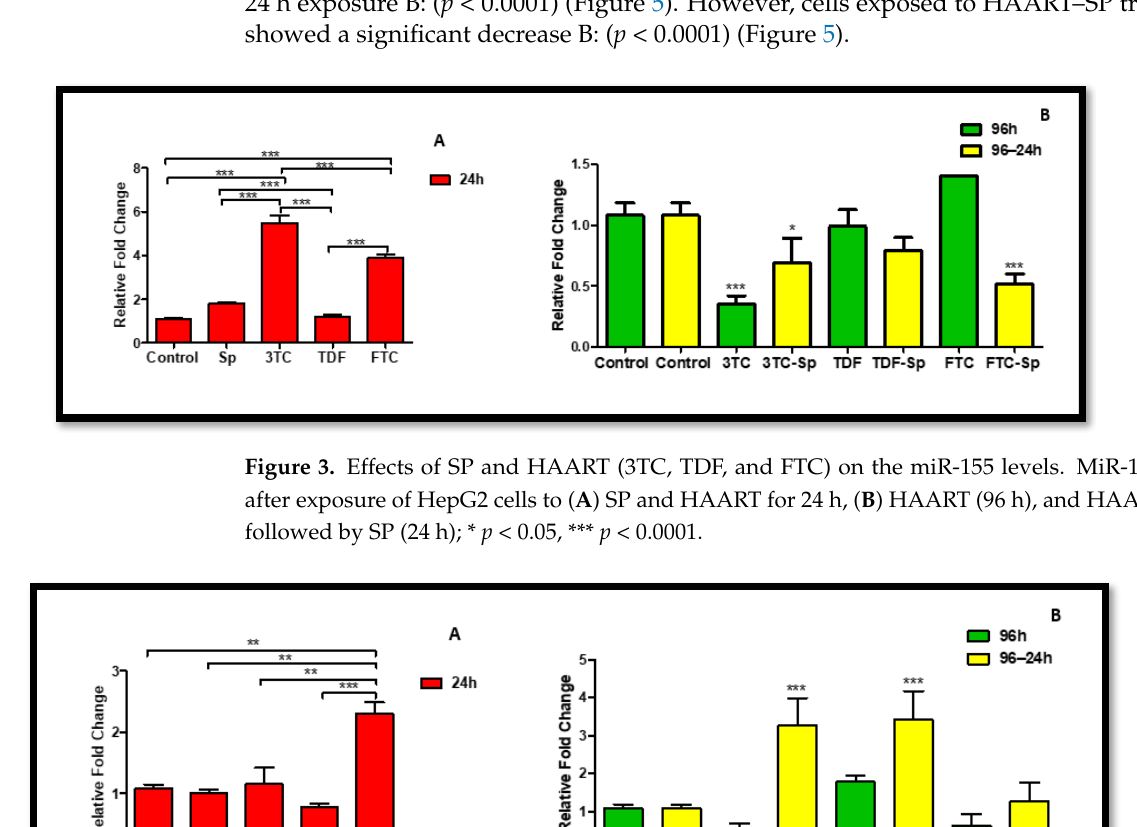
Figure 3. Effects of SP and HAART (3TC, TDF, and FTC) on the miR-155 levels. MiR-155 levels after 24 h exposure A: ( p < 0.0001), and mostly reduced in HAART (except 3TC)-treated cells after exposure of HepG2 cells to ( A ) SP and HAART for 24 h, ( B ) HAART (96 h), and HAART (96 h) 24 h exposure B: ( p < 0.0001) (Figure 5). However, cells exposed to HAART–SP treatment followed by SP (24 h); * p < 0.05, *** p < 0.0001 . showed a significant decrease B: ( p < 0.0001) (Figure 5).